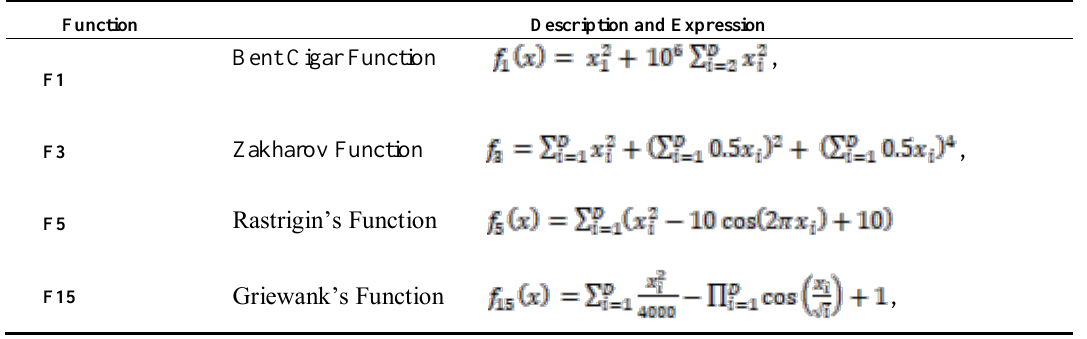
Table 1: Basic Benchmark Functions.